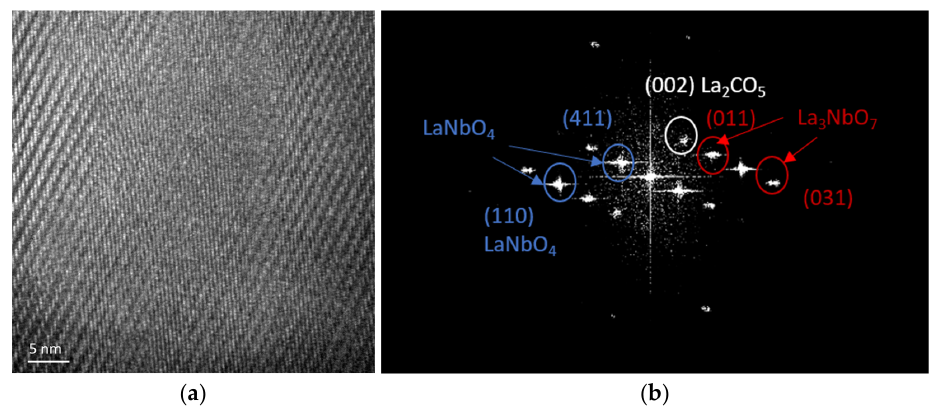
Figure 7. ( a ) Cross-section HRTEM micrographs of the LaNbO external layer of the HT-HP sample; ( b ) Fast Fourier Transform (FFT), equivalent to the experimental electron diffraction patterns, of Figure 7a. The red spots correspond to La 3 NbO 7 , blue spots correspond to LaNbO 4 and white spots correspond to La 2 CO 5 .